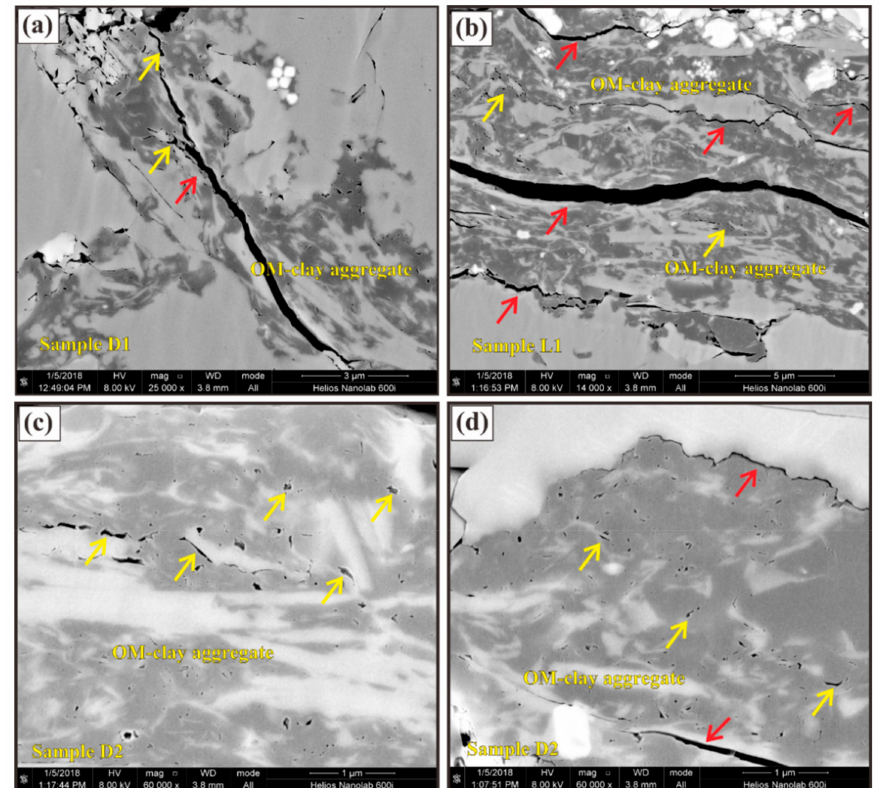
Figure 11. SEM photomicrograph images of OM–clay aggregates and their related pore networks. Natural thermally or tectonically controlled fractures are indicated with red arrows whereas the OM pores are indicated with yellow arrows. ( a ) SEM image showing OM–clay aggregates of sample D1; ( b ) SEM image showing OM–clay aggregates and their related shrinkage crack pores and microfractures of sample L1; ( c ) SEM image showing OM–clay aggregates and their related pore systems within sample D2; ( d ) SEM image showing OM–clay aggregates and their related pore systems within sample